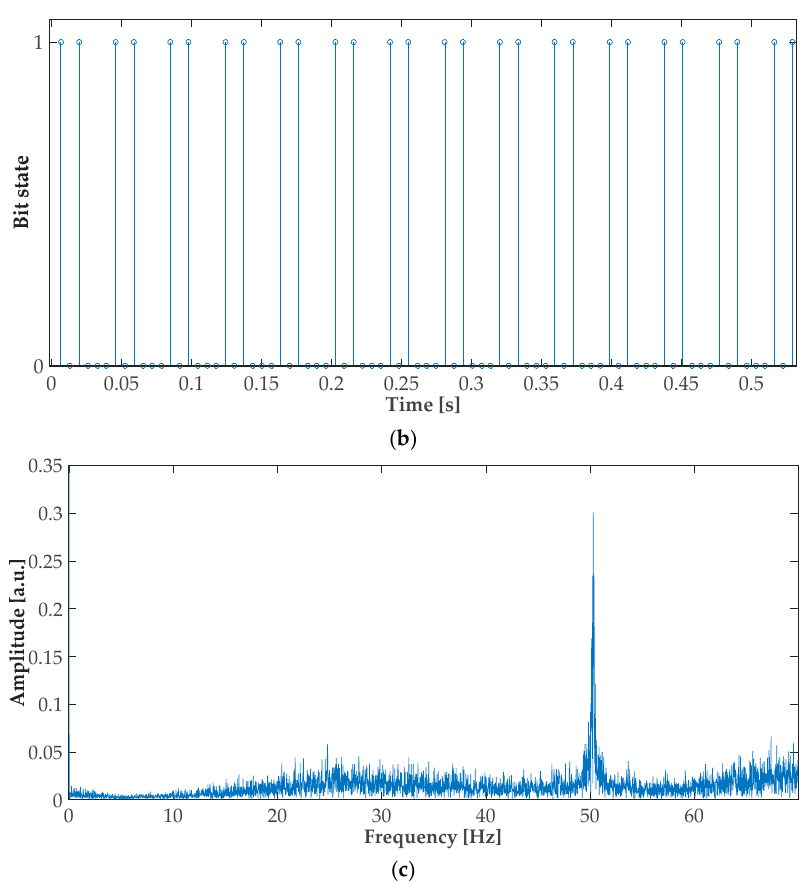
Figure 3. Touch signal characteristics. ( a ) Input signal to the controller before and after the touch event; ( b ) Digital signal received by the controller in the case of a touch event; ( c ) Frequency spectrum of the signal resulting from the touch event.